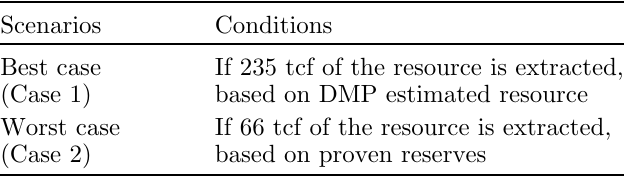
Table 2. Emission factors from upstream, midstream and downstream